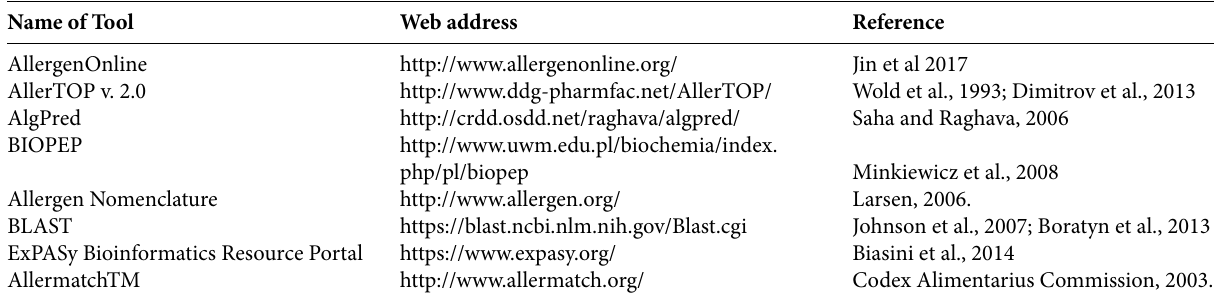
Table 1 . Some selected online bioinformatics